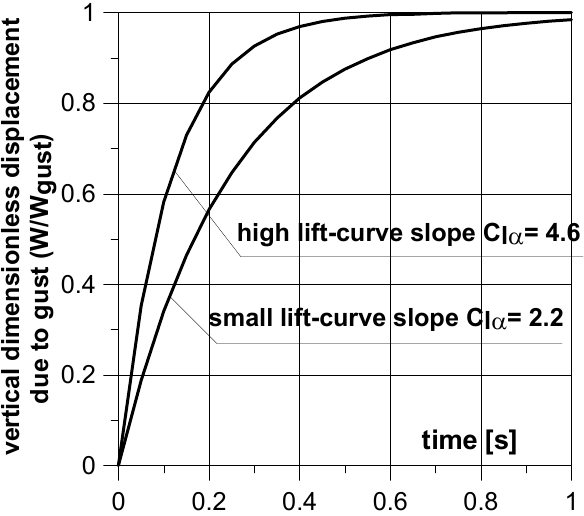
Fig 21. A simple physical model explaining why an aircraft with a lower aspect ratio (and therefore with a in lower lift-curve slope) is less sensitive to gusts than one with a higher aspect ratio